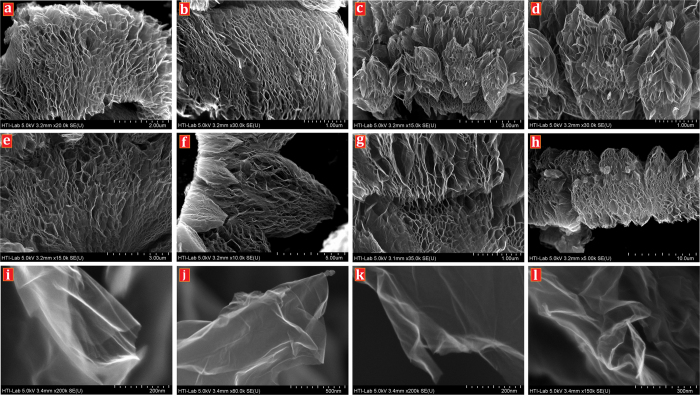
FESEM images of the CE-GR (3a–h) and T-GR (3i–l).